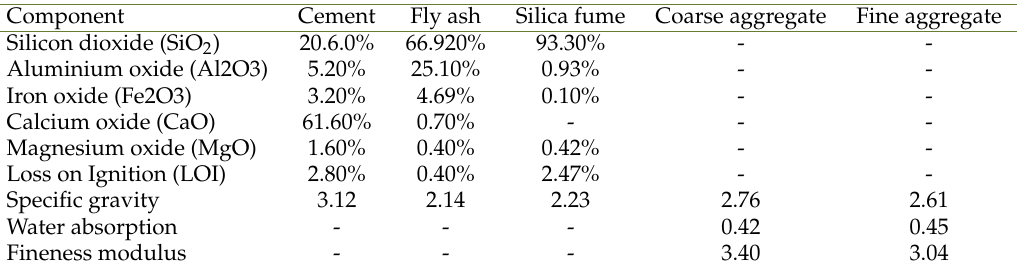
Table 1. Physical and chemical properties of binding materials and aggregates